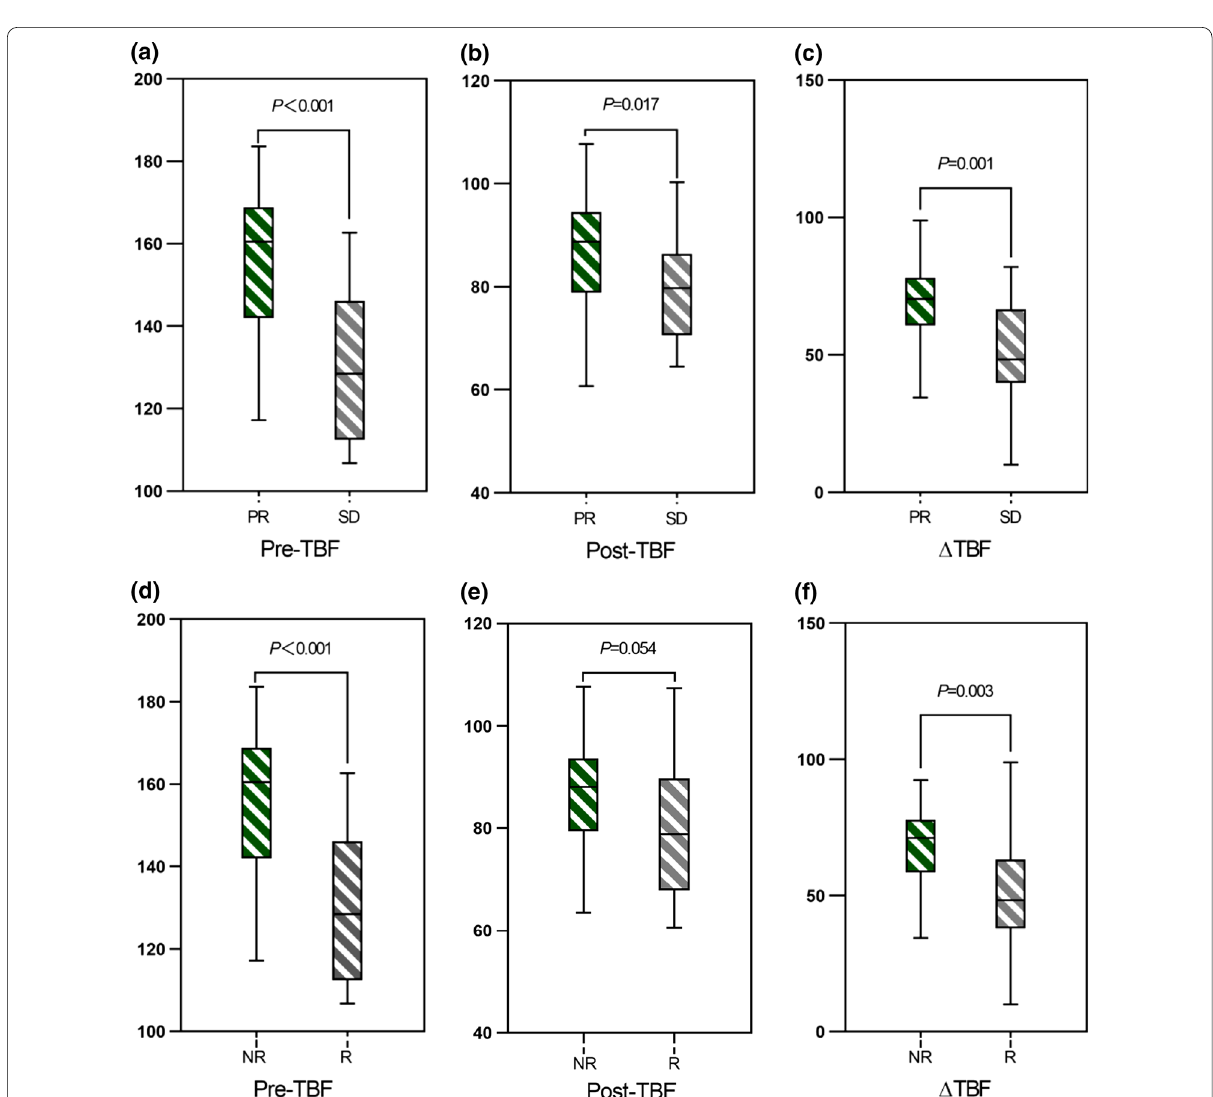
Fig. 5 Box plots demonstrated the inter-group differences in ASL-derived parameters between the PR and SD groups, as well as between the residual and the non-residual groups. The horizontal line denotes the median values of the parameters (the 50th percentile). The top and bottom of the box denote the 25th and the 75th percentile, respectively. As can be observed from the box plots, Pre-TBF and ΔTBF can distinguish between the PR and the SD group, as well as between the residual and the non-residual group ( a , c , d , and f ), whereas the Post-TBF of the residual group showed an overlap with the non-residual group ( b and e ). Pre-TBF: pre-treatment tumor blood flow; Post-TBF: post-treatment tumor blood flow; ΔTBF: changes in tumor blood flow; PR: the partial response group; SD: the stable disease group; R: the residual group; NR: the non-residual